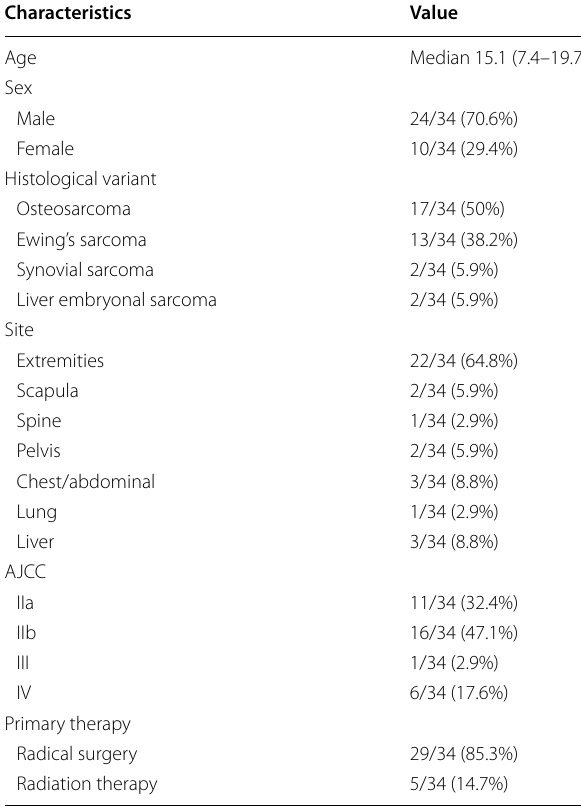
Table 1 Study population